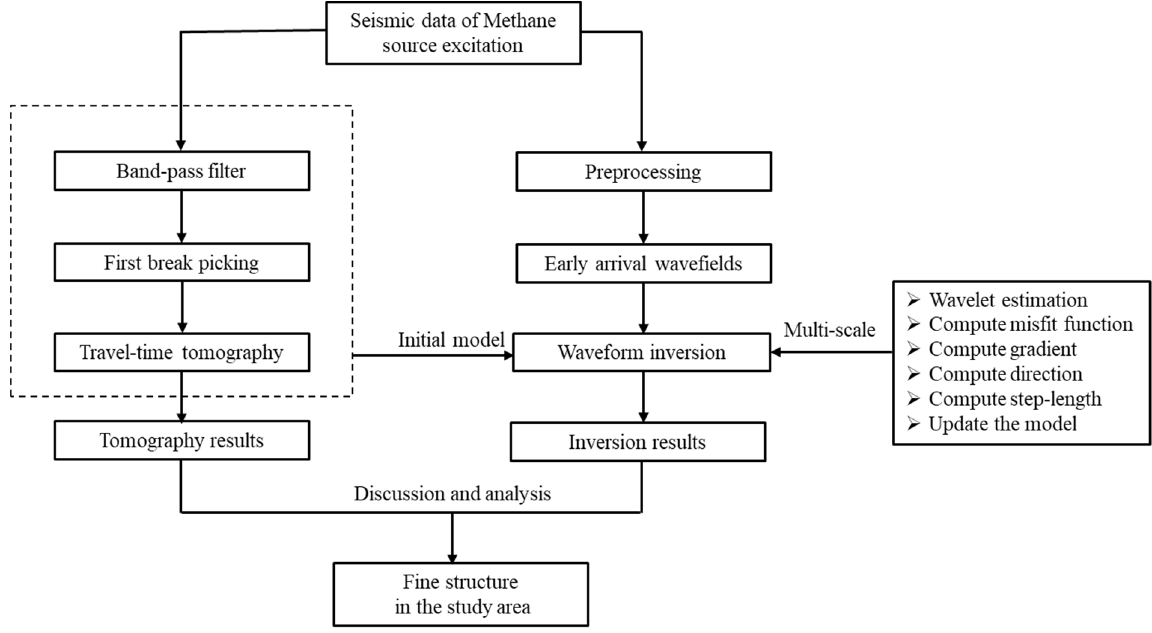
Figure 8. Schematic illustrating our workflow.